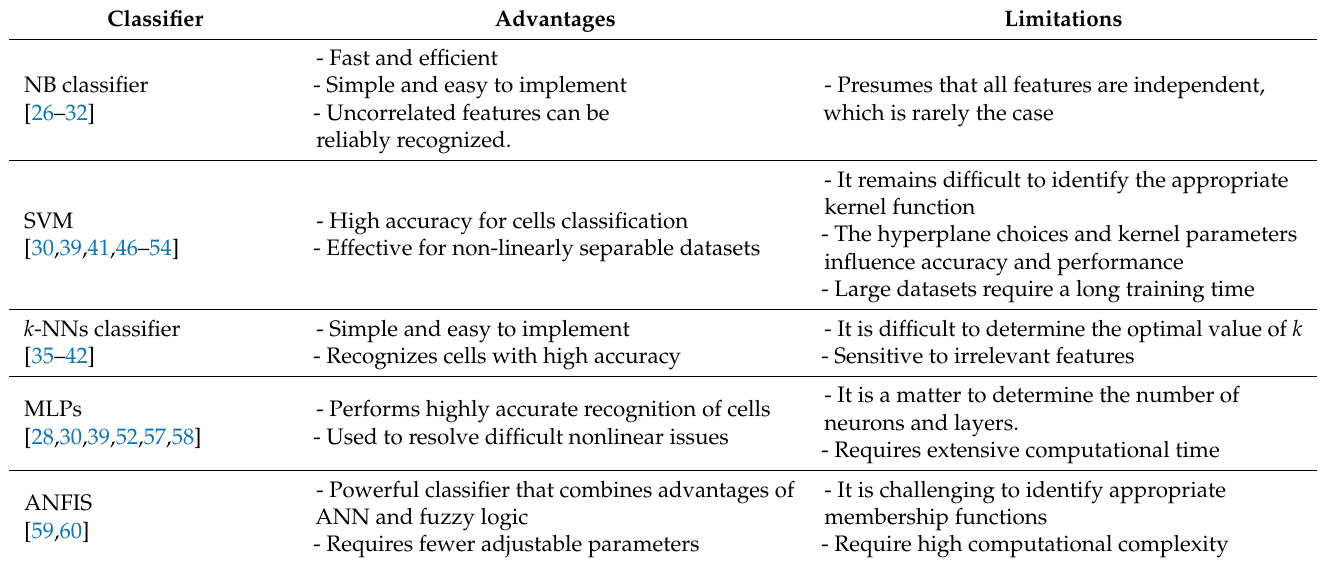
Table 1. Microscopic cell image classification methods overview: advantages and